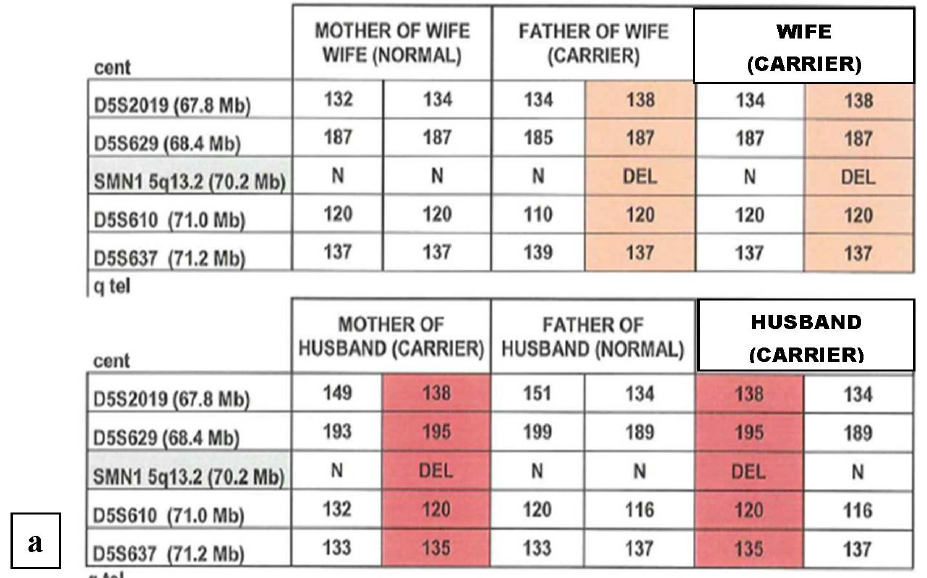
Figure 1. Pre-PGD workup for a family with a previous child with spinal muscular atrophy. Panel ( a ) shows how the study of both parents and grandparents allows the phasing of the SMN mutation relative to polymorphic short tandem repeat (STR) markers; panel ( b ) shows the maternal and paternal haplotypes M1, M2, P1 and P2 and the distance of the STR markers from the SMN gene; panel ( c ) shows the four predicted fetal haplotypes. These reflect a Hardy–Weinberg equilibrium of one homozygous non-carrier, two heterozygous carriers and one that is homozygous and affected. Short tandem repeat markers linked with the SMN mutation are shown in red. DEL indicates the presense of the exon 7 (840 C>T)